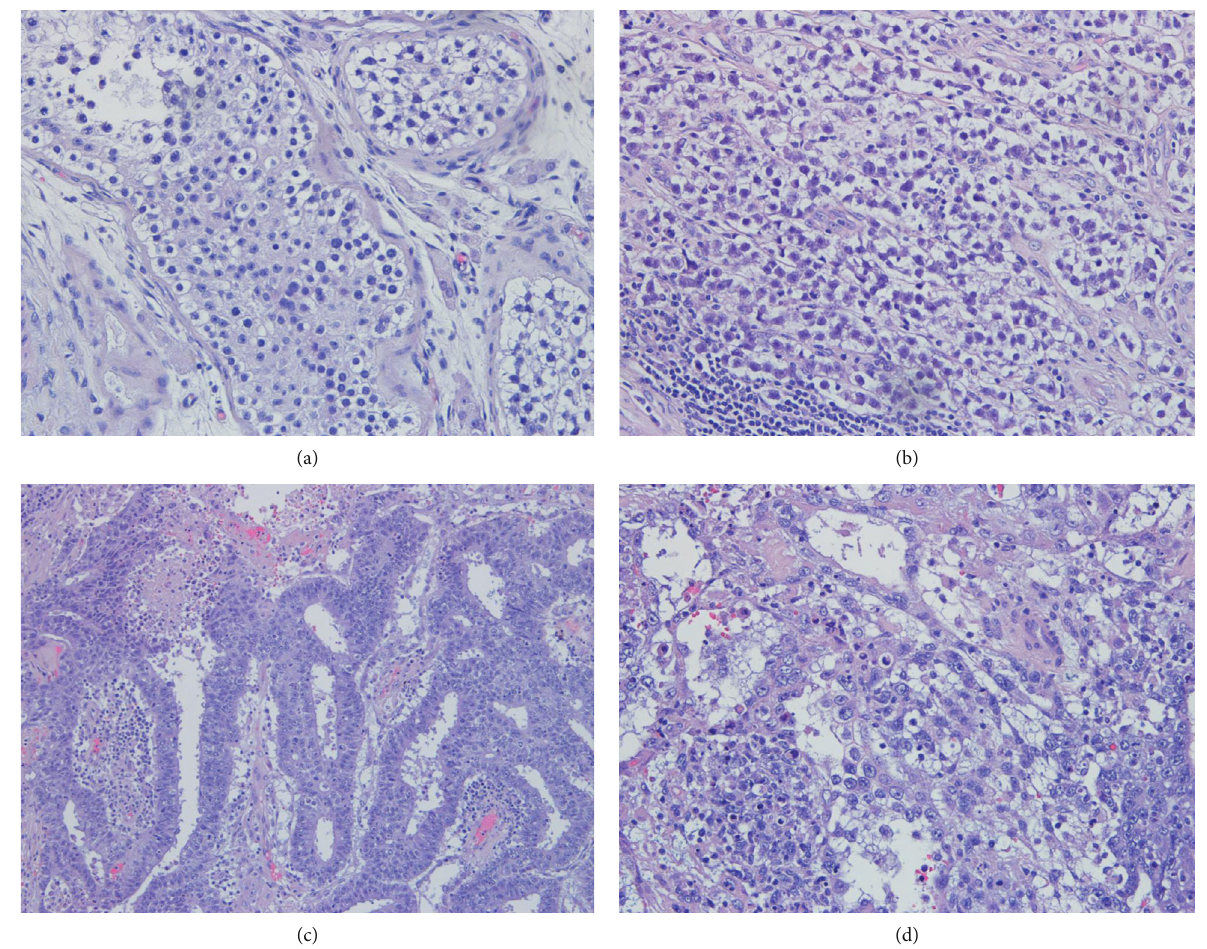
Figure 4: Testicular involvement by mixed germ cell neoplasm associated with germ cell neoplasia in situ (a, H&E 200x), with seminoma- type components (b, H&E 200x), embryonal carcinoma type (c, H&E 200x), and yolk sac type (d, H&E